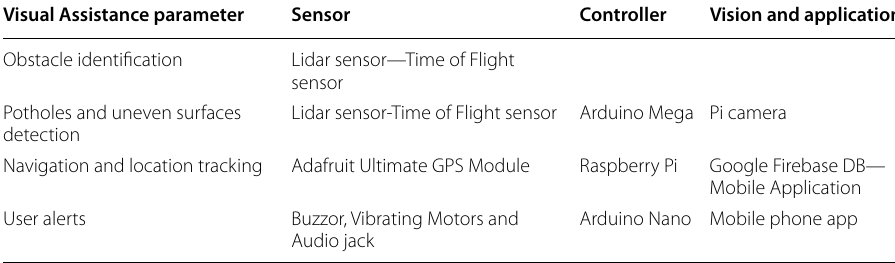
Table 2 Functionalities of multi-sensor fused navigation